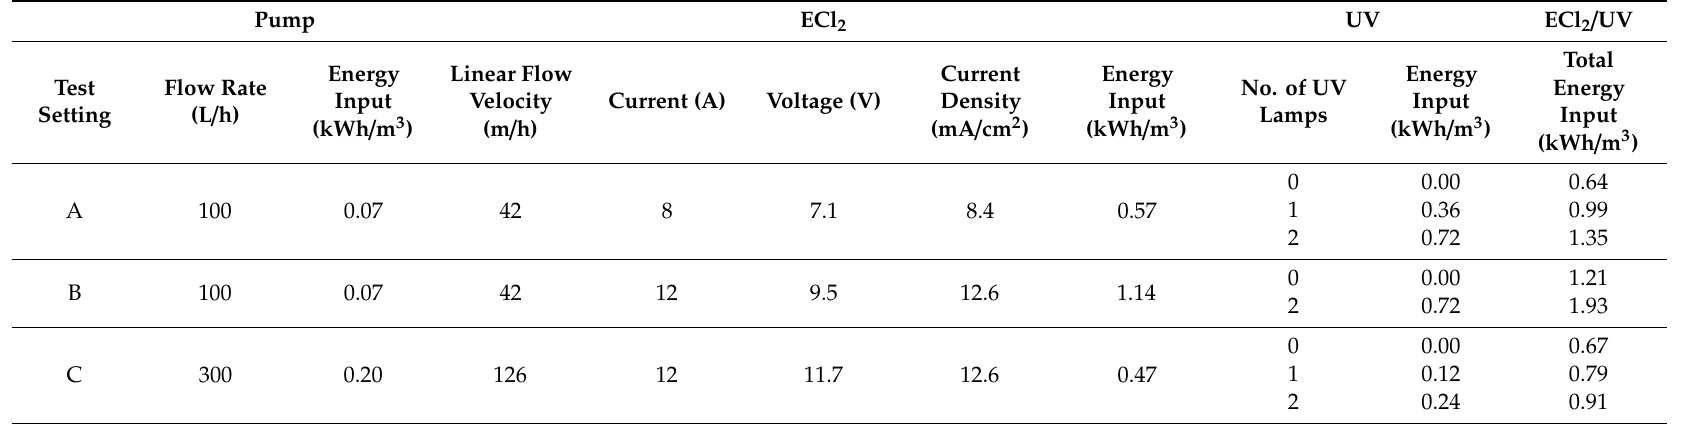
Table 1. Test matrix and energy requirements for the di ff erent field test settings of UV / ECl 2 . ECl 2 UV ECl 2 /